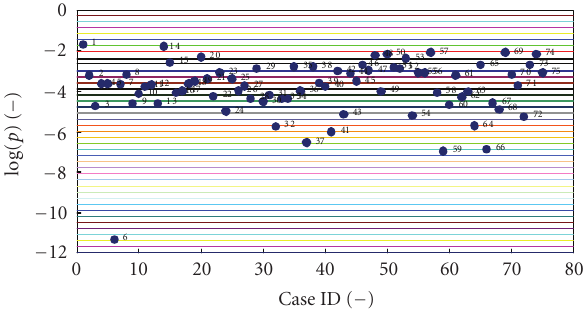
Figure 19: Characterization of system status on the basis of the probability. Six system status (1 to 6 in the figure) is determinis- tically derived and sixty-nine (7 to 75 in the figure) are statistically derived assuming a discrete probability distribution.